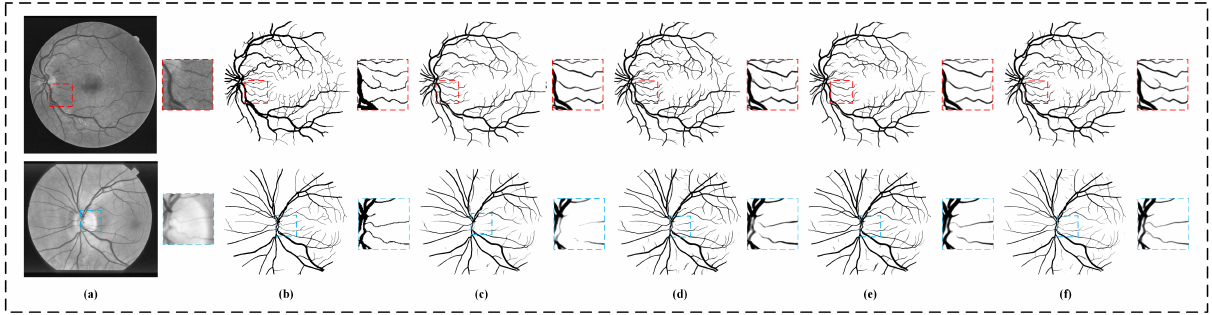
Figure 8. The model segmentation results with different channel attention modules integrated. The top row is the result on the DRIVE dataset, and the bottom row is the one on the STARE dataset. ( a ) The original image, ( b ) the ground truth, ( c ) the segmentation result of Basenet, ( d ) the segmentation result integrated with SE module, ( e ) the segmentation result integrated with CA module and ( f ) the segmentation result integrated with